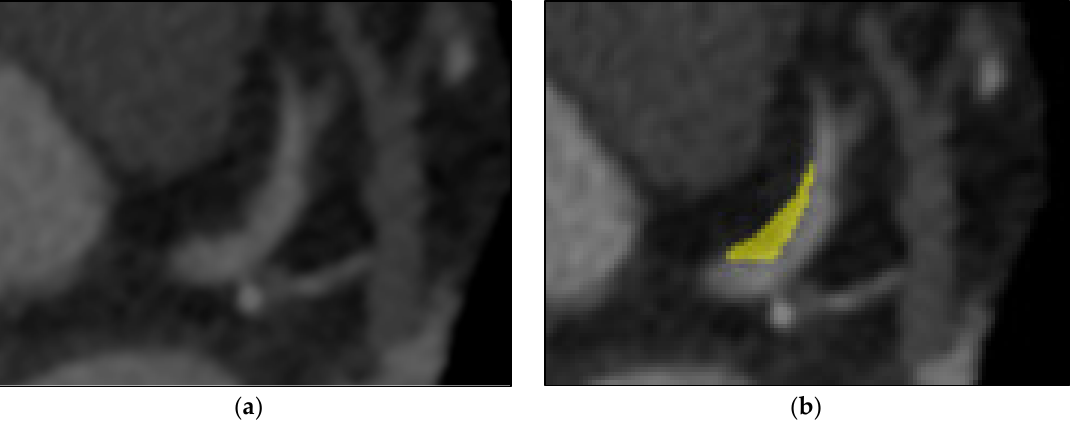
Figure 4. ( a ) Before segmentation of proximal LAD and ( b ) after segmentation of non-calcified lesion on proximal LAD using semi-automated (growth from seed) type of segmentation which was colored into yellow colour.